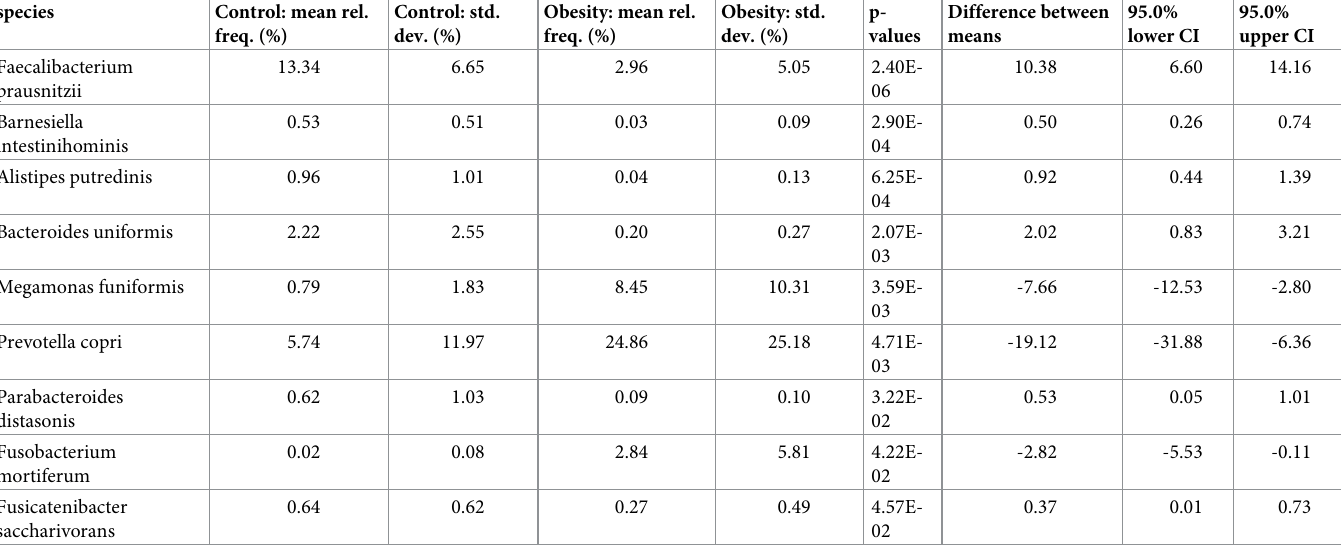
Table 2. Significantly different species of gut microbiota between the Obesity and Control groups. species Control: mean rel.